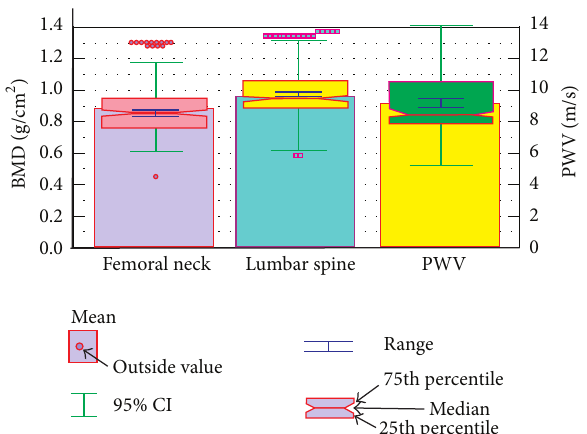
Figure 2: Box plots of the mean, range, median, and 25th and 75th percentiles for tissue biomarkers: femoral neck BMD, lumbar spine BMD, and PWV. Mean, 95% CI of the mean, range, median, 25th and 75th percentiles presents femoral neck BMD and lumbar spine BMD. BMD: bone mineral density; PWV: pulse wave velocity; CI: confidence interval.